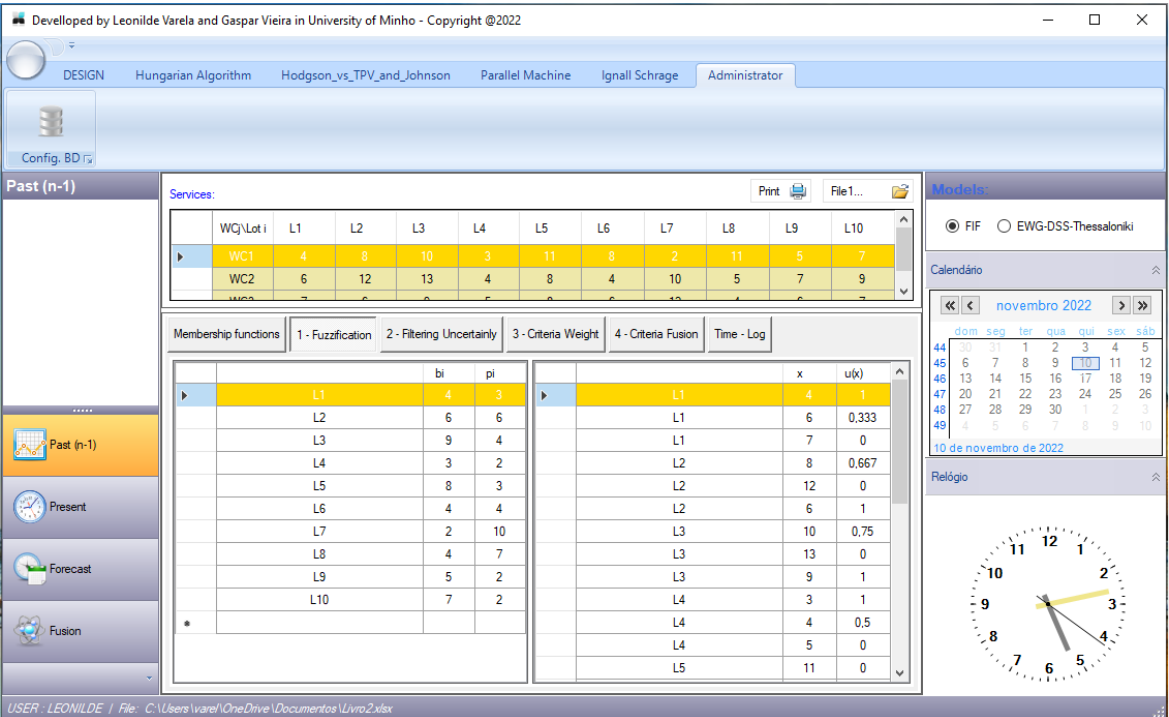
Figure 4. Scheduling system interface illustration.